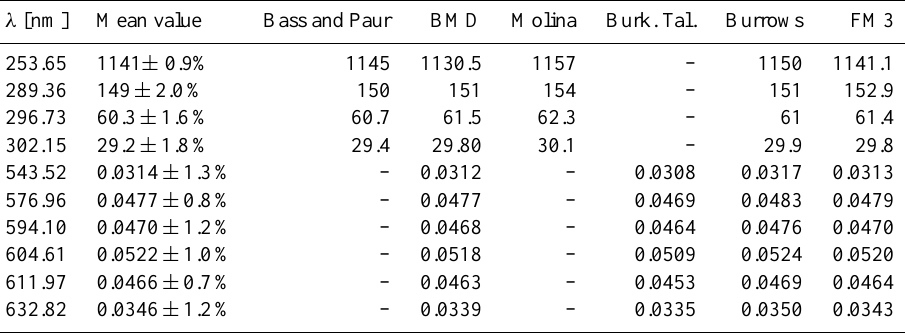
Table 2. Comparison of GOME-2 FM3 ozone cross section with literature data at ten selected wavelengths at room temperature. The absorption cross sections are given in units of 10 − 20 cm 2 , the second column indicates the mean from all available literature data at 298 ± 5K provided by the ESA study (Orphal, 2002).